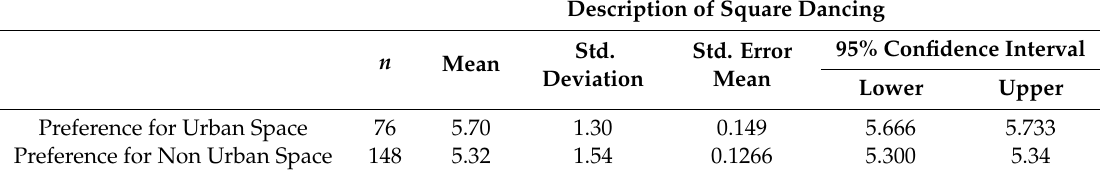
Table 15. Two-Sample T-test with unequal variances comparing a negative description of Square Dance Music with preferences for urban or non urban spaces.